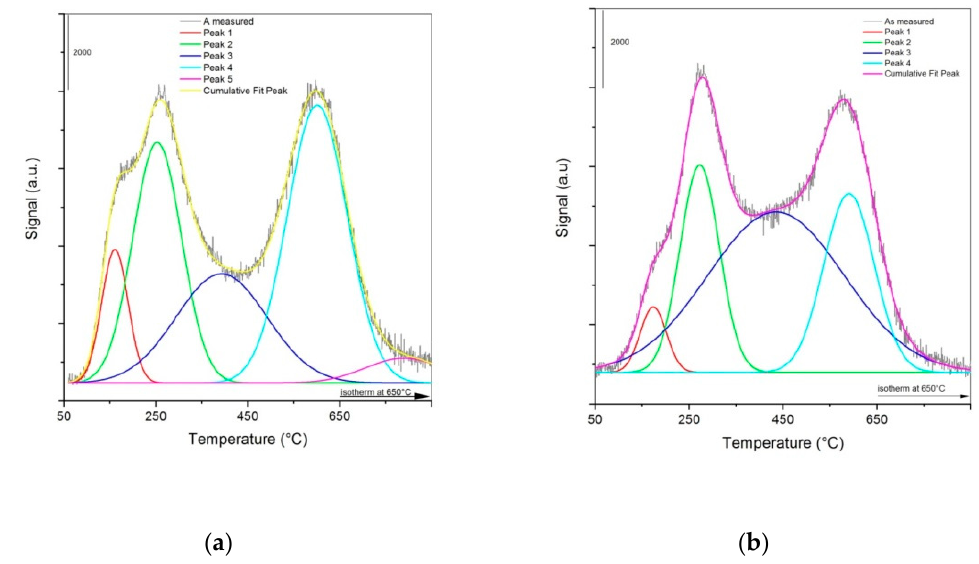
Figure 4. NO signal from TPD-NO over ( a ) K/Co 4 MnAlO x -500 and ( b ) K/Co 4 MnAlO x -700.